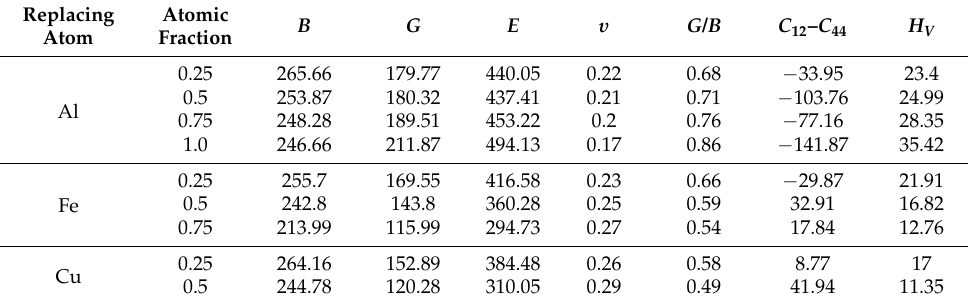
Table 14. The calculated bulk modulus B (GPa), shear modulus G (GPa), Young’s modulus E (GPa), Poisson’s ratio υ , Pugh’s ratio G / B , Cauchy pressure C 12 – C 44 , and Vickers hardness H V for Ti (1 − x) M x N